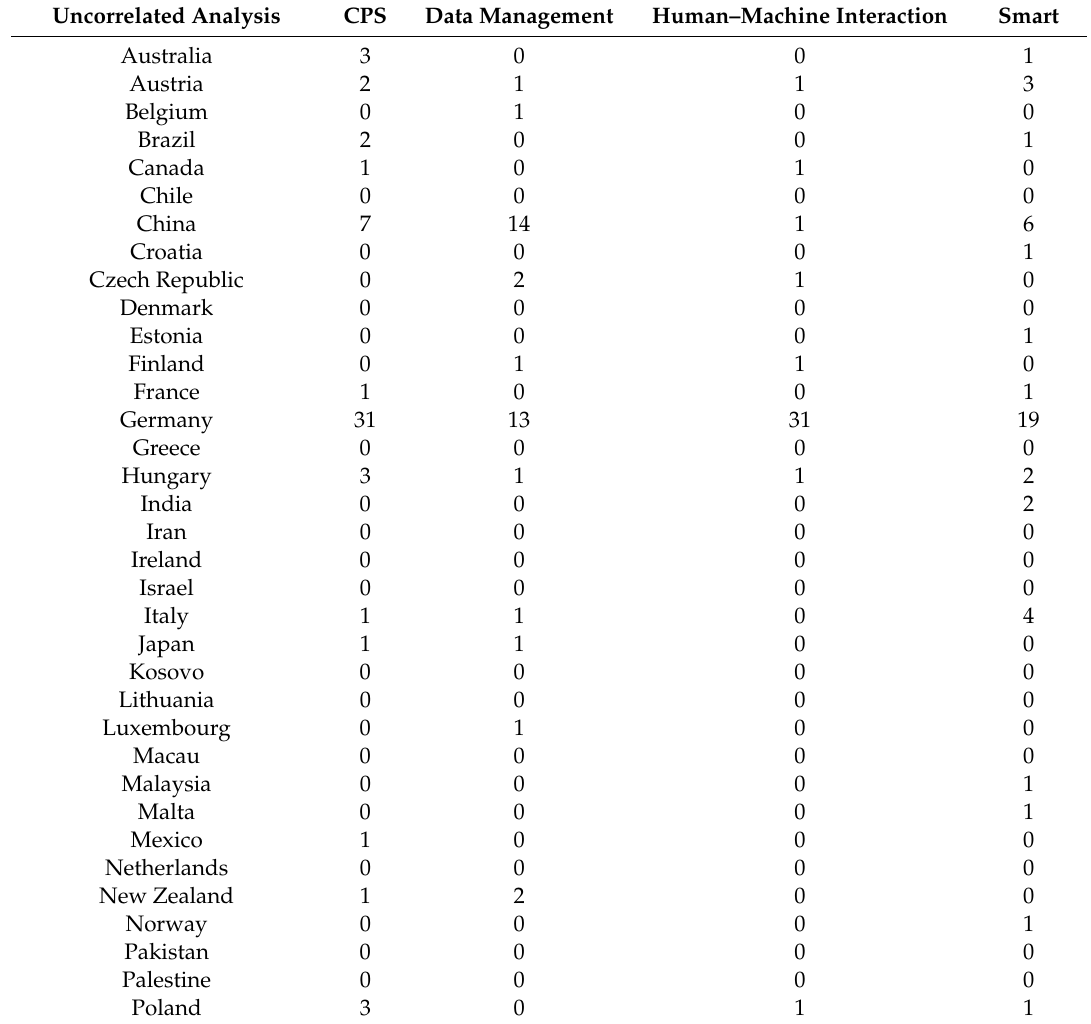
Table A2. Amount of papers identified in the correlated international